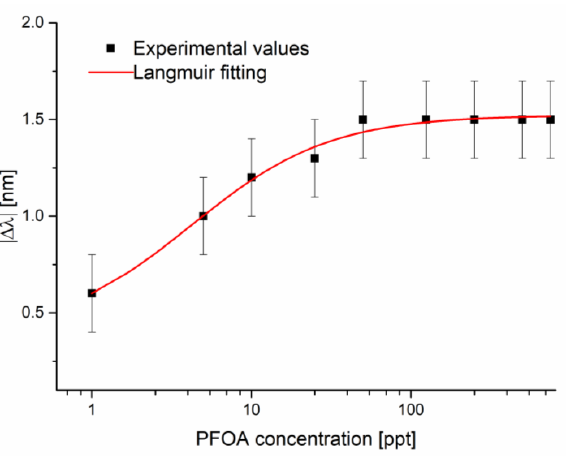
Figure 7. The absolute value of the resonance wavelength variations (calculated with respect to the blank) versus PFOA concentration in seawater, with the error bars and Langmuir fitting on a semi-log scale. Table 3. The Langmuir parameters relative to the PFOA detection in simulated seawater.